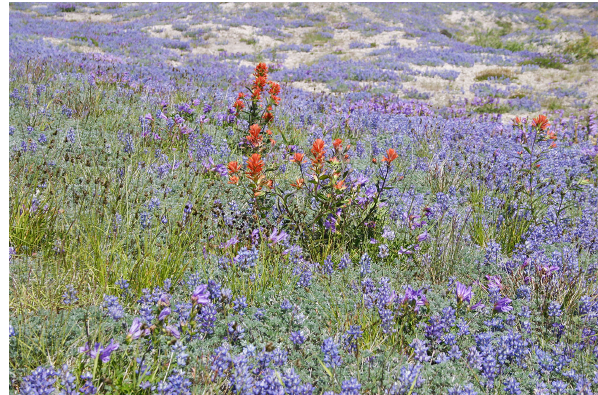
Fig. 8. Upper Pumice Plain plots showing a bloom of Lupinus lep- idus with Castilleja miniata (Photo: RdM 2007).